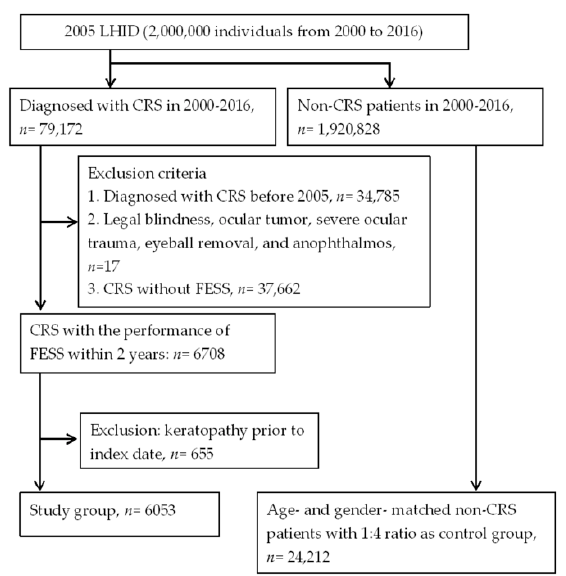
Figure 1. The flowchart of patient selection. LHID: Longitudinal Health Insurance Database; CRS: chronic rhinosinusitis; FESS: functional endoscopic sinus surgery.